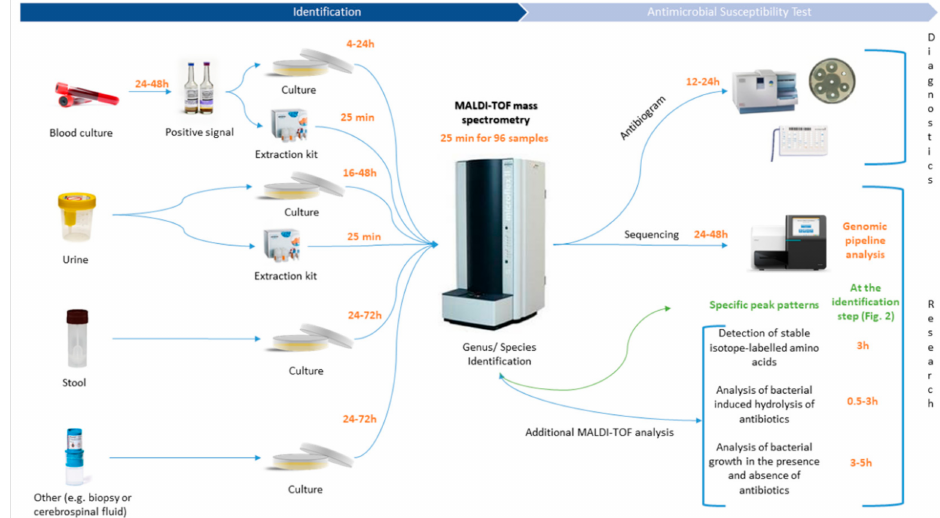
Figure 1. MALDI-TOF MS related analysis workflow in clinical routine diagnostic and research